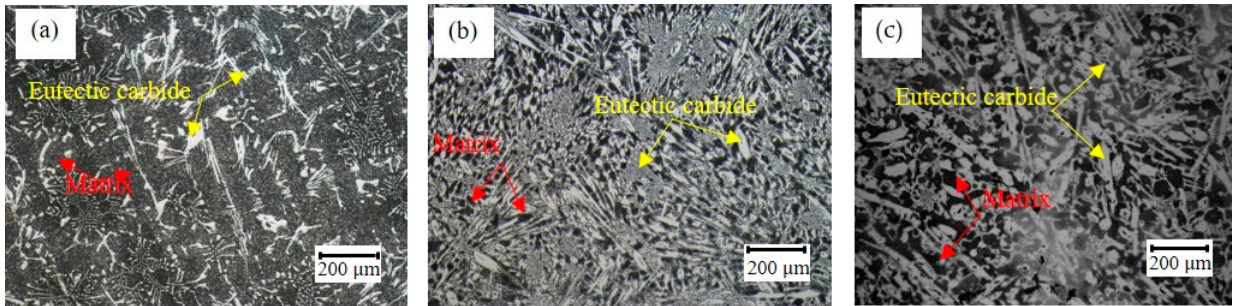
Figure 3. X-ray diffraction patterns of ( a ). MWCI; ( b ). 18Cr MWCI as–Q; ( c ). 27Cr MWCI as–Q.